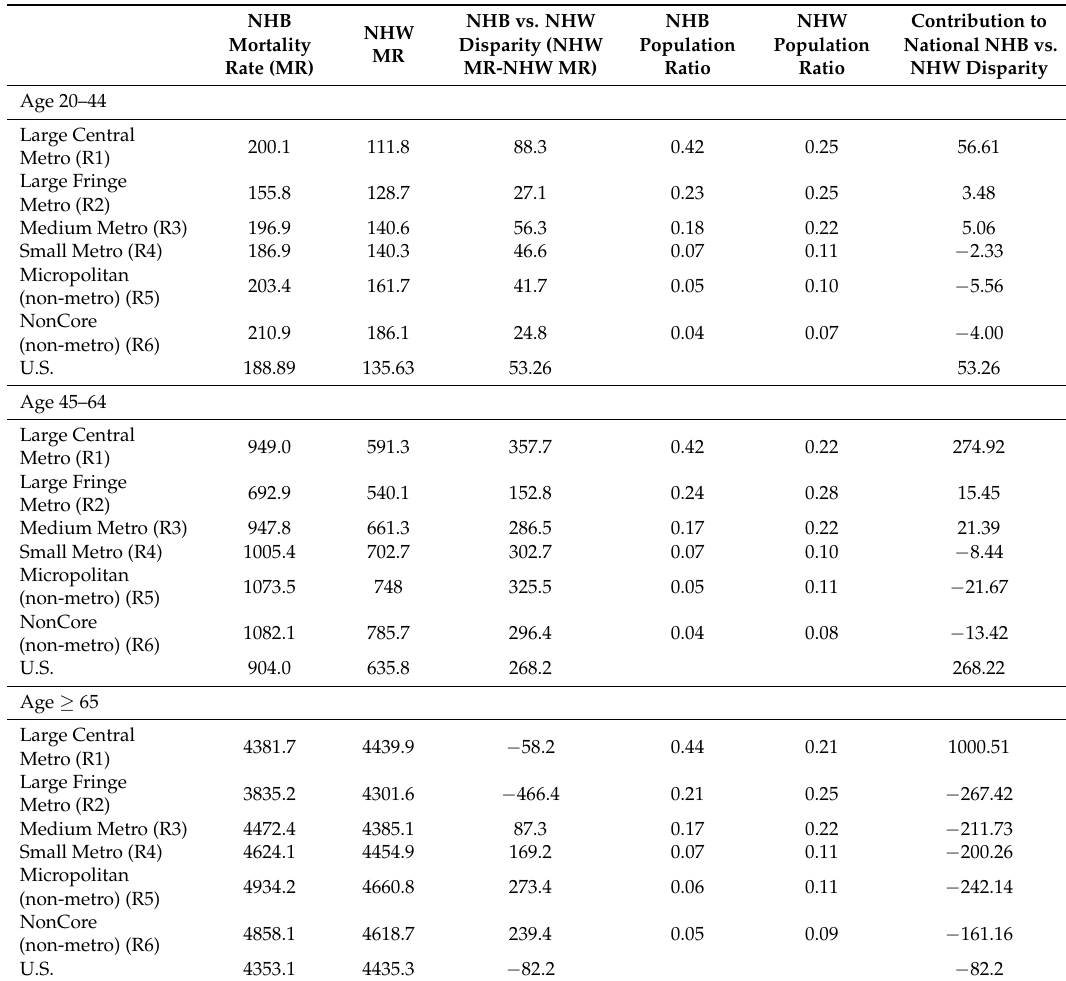
Table 9. Contribution of the six rural-urban areas to age-specific disparities in all-cause mortality rates per 100,000 population between NHB (NHB) and NHW (NHW) populations in the U.S.—National Vital Statistics System, United States,